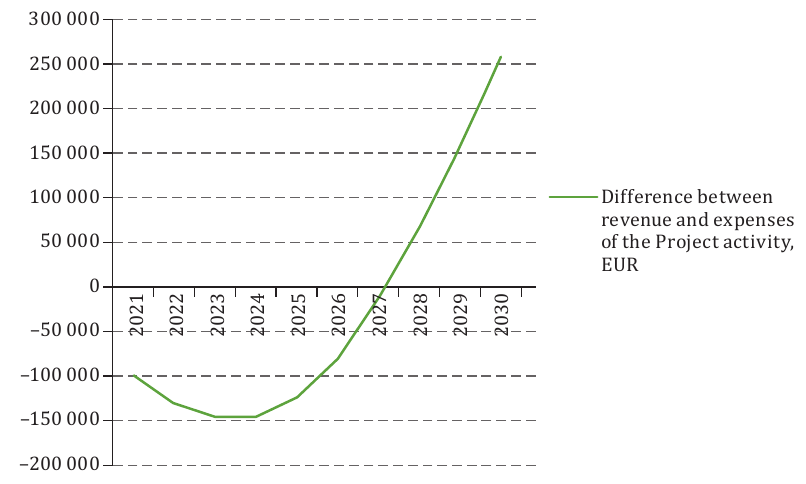
Figure 3. Payback of the project in estimating operating costs (created by the